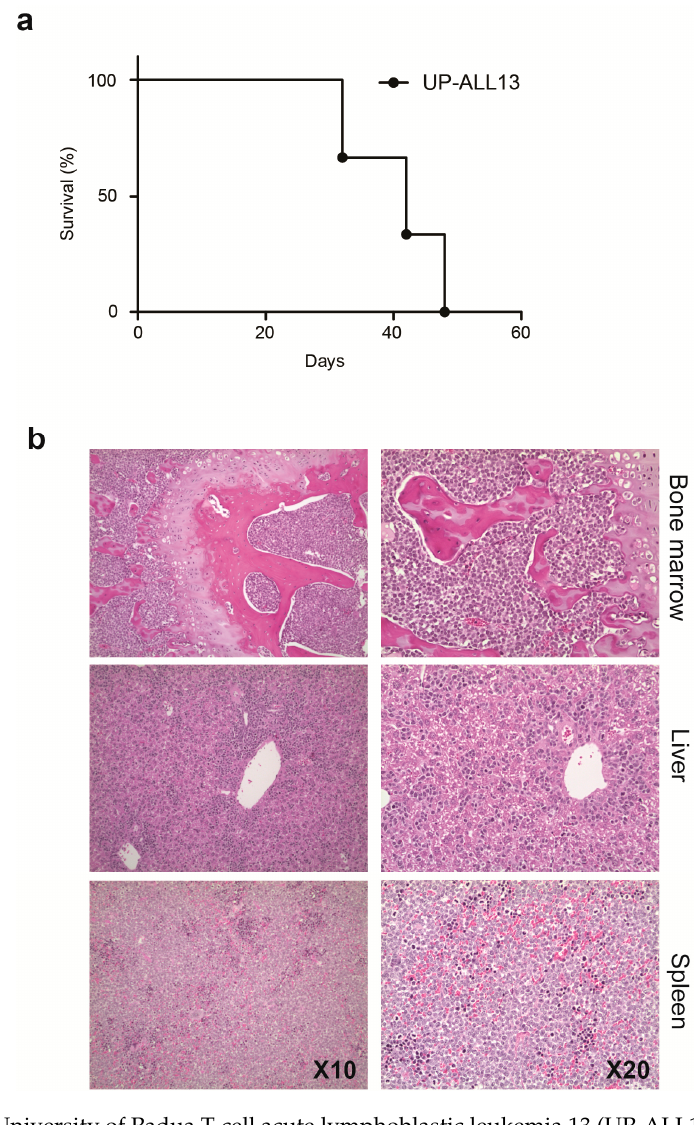
Figure 1. The University of Padua T-cell acute lymphoblastic leukemia 13 (UP-ALL13) engrafts into Nonobese diabetic/severe combined immunodeficiency (NOD/SCID) interleukin 2 receptor gamma chain null (IL2R γ null) (NOD SCID IL2R γ null ; NSG) mice and induces leukemia. ( a ) Survival curve for NSG mice engrafted intravenously with UP-ALL13 cells (5 × 10 6 cells; n = 3). ( b ) Histology of representative infiltrated organs of moribund mice (hematoxylin and eosin staining; H&E). Magnification: × 10 (left panels); × 20 (right panels).